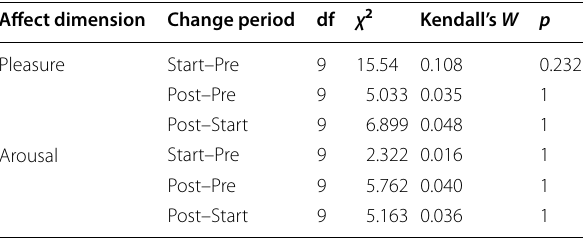
Table 3 Changes in arousal and pleasure across measurement times with material as a dependent variable—results of the Friedman